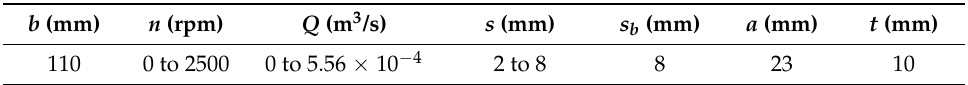
Figure 6. Test rig design: ( a ) Cross section of the test rig; ( b ) View along “ A ” direction; ( c ) Shaft sealing and ( d ) Test rig. F a : axial thrust; r seal : radius of shaft seal. Table 1. Parameters of the